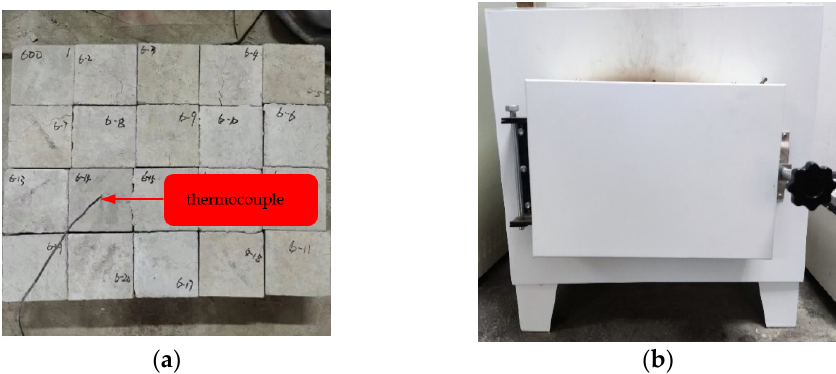
Figure 2. High temperature treatment of concrete specimens. ( a ) Heated concrete specimens. ( b ) Muffle